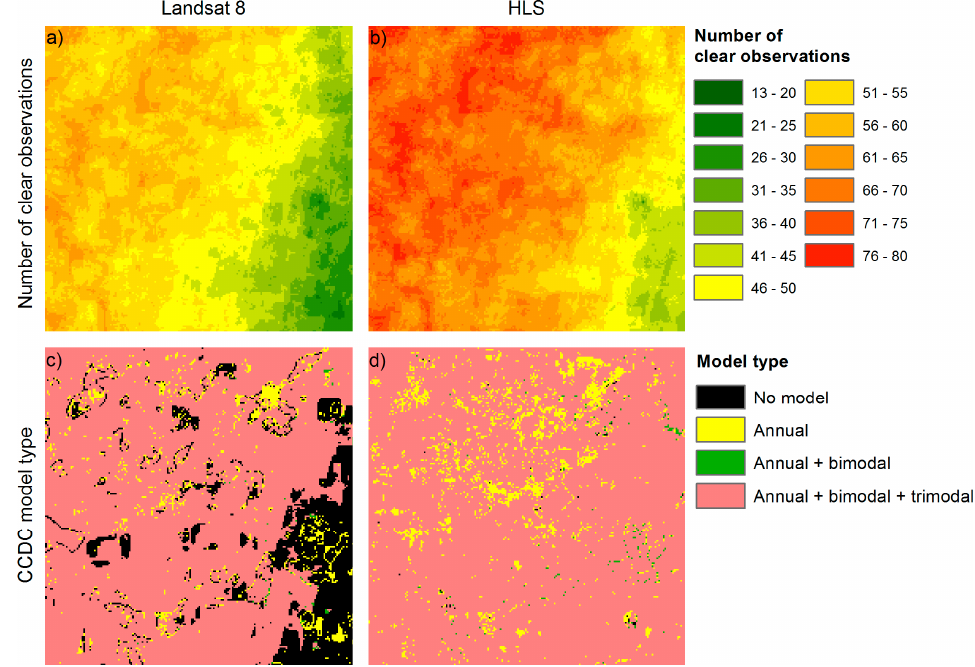
Figure 10. The top row indicates all available clear observations for the ( a ) Landsat-8 and ( b ) HLS time series for 2016. The bottom row shows the harmonic frequencies selected by CCDC 2016 models for both ( c ) Landsat-8 and ( d ) the HLS data.